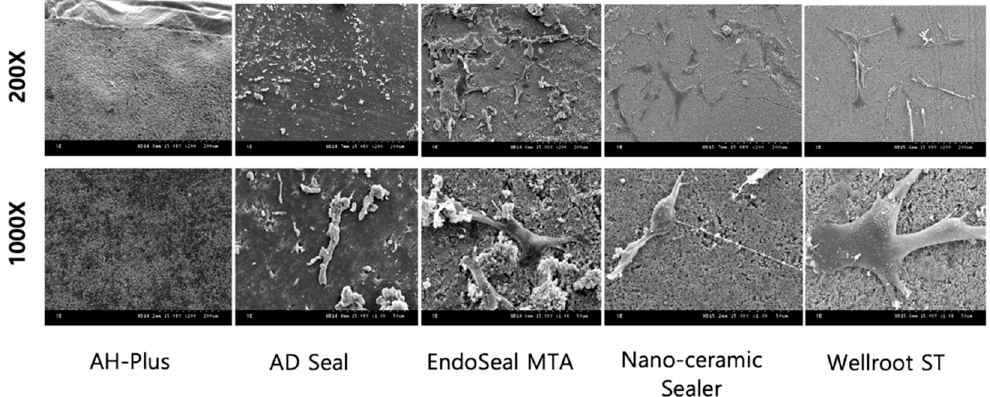
Figure 4. The morphology of hPDLSCs attached on the surface of five root canal sealers after culture for 3 days at a magnification of 200 × (upper row) and 1000 × (lower row). Cell death was observed (no cell adhesion detected) in AH-Plus and AD Seal, while three calcium silicate-based sealers allowed well-adhered cells with high degree of cell spreading and production of extracellular matrix.